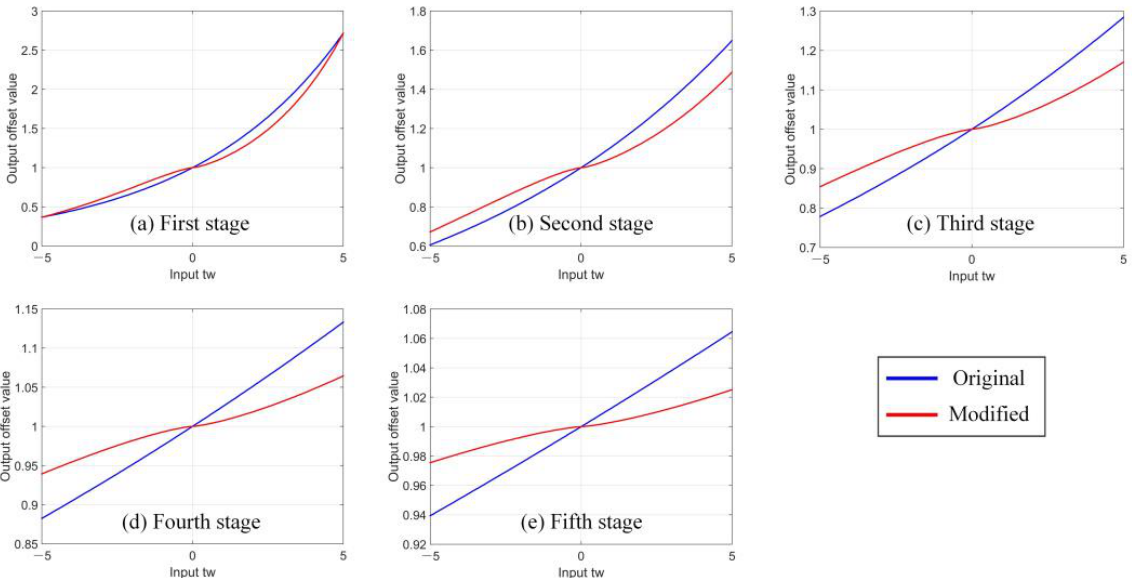
Figure 4. Input offsets 𝑡 𝑥 vs. bounding box output offset 𝑔 𝑥 − 𝑝 𝑥 plotted for the original and modified loss functions. Following the settings in Cascade R-CNN, the weight 𝑐 𝑥 is set as 10, 20, 40, 80, and 160 for the first to the fifth stage, respectively.